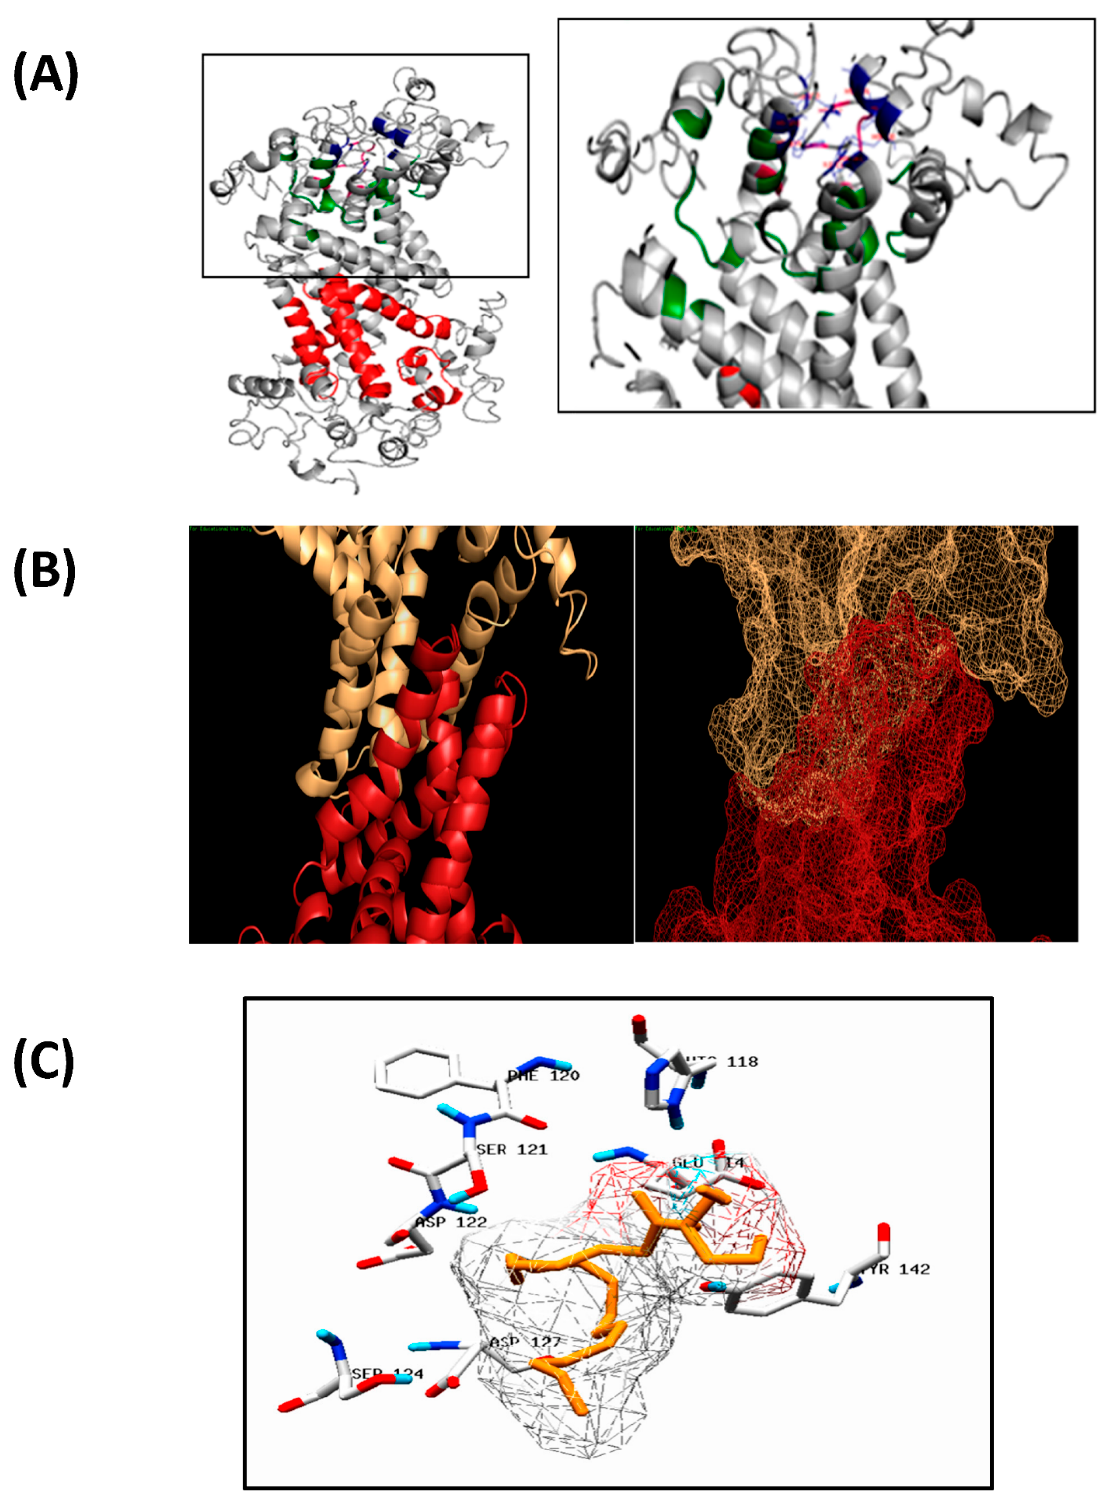
Figure 3. ( A ) EoFAD2 homodimer organization taking into account the hydrophobic interactions; ( B ) Potential substrates and substrate-binding residues; ( C ) Substrate oleoyl glycerol docked with the predicted structure of Elaeis oleifera FAD2 . Table 7. Transmembrane domains as predicted by TMPred.